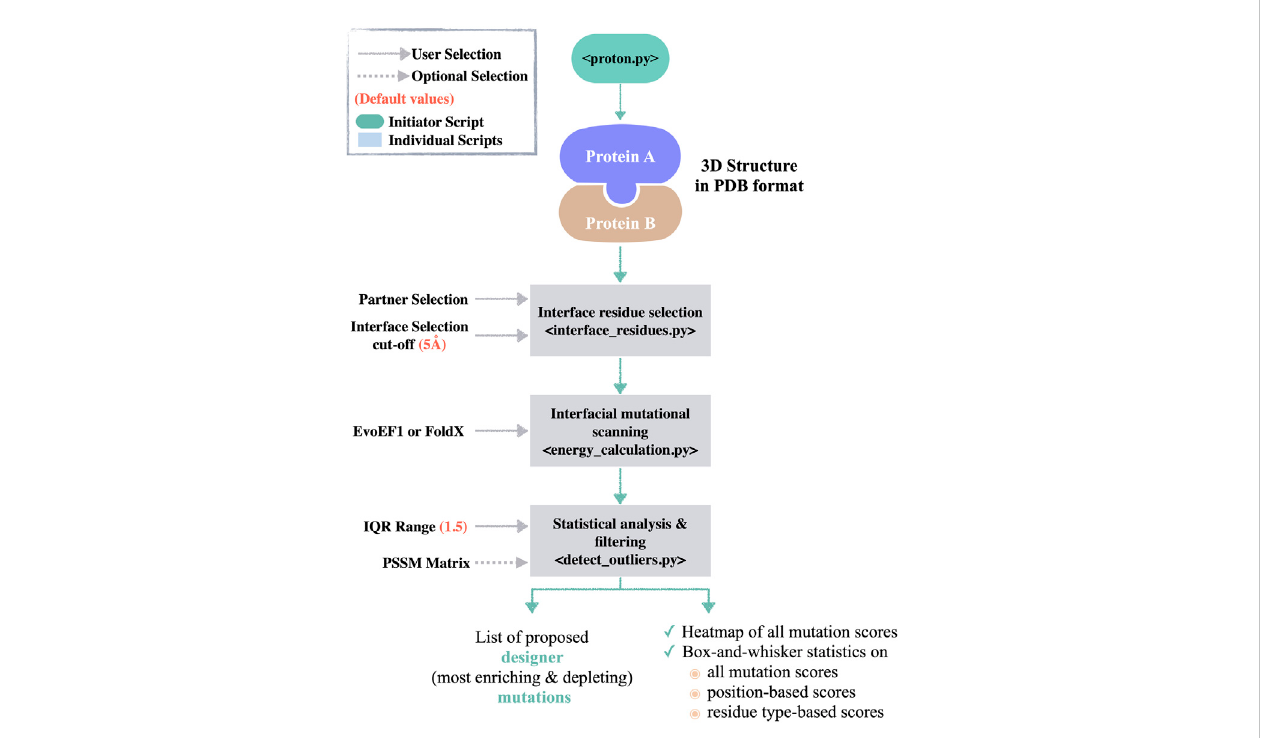
FIGURE 1 The PROT-ON pipeline. The proton.py calls the individual scripts, i.e., interface_residues.py , energy_calculation_EvoEF1.py/energy_calculation_ FoldX.py , and detect_outliers.py . The default values for the user-de fi ned parameters are denoted in